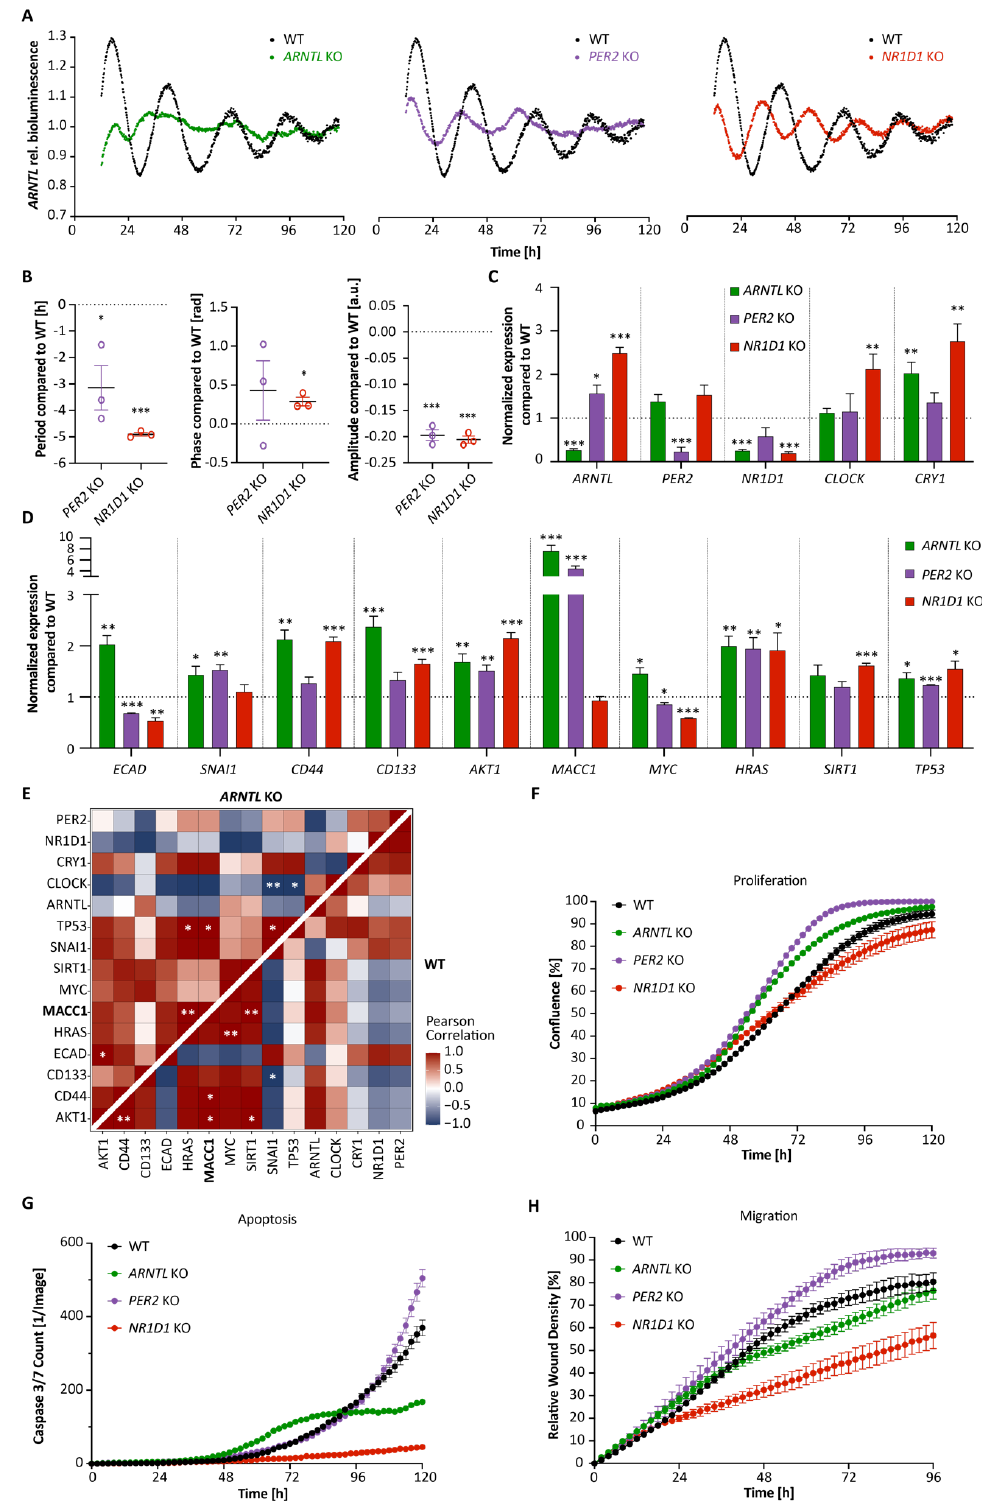
Figure 1. ARNTL promoter activity shows different oscillation patterns in HCT116 knockout cell lines. ( A ) Bioluminescence readouts for the promoter activity of ARNTL over the course of 120 h in HCT116 WT and CC knockout ( ARNTL KO, PER2 KO and NR1D1 KO) cell lines. ( B ) Period, phase and amplitude analysis of bioluminescence data of HCT116 knockout cells using Chronostar ( n = 3, mean ± SEM). T WT = 26.1 ± 0.1 h, T ARNTL KO = ND, T PER2 KO = 23.0 ± 0.8 h, T NR1D1 KO = 21.2 ± 0.1 h. ( C ) Gene expression analysis of CC genes PER2 , CRY1 , NR1D1 , CLOCK , and ARNTL in HCT116